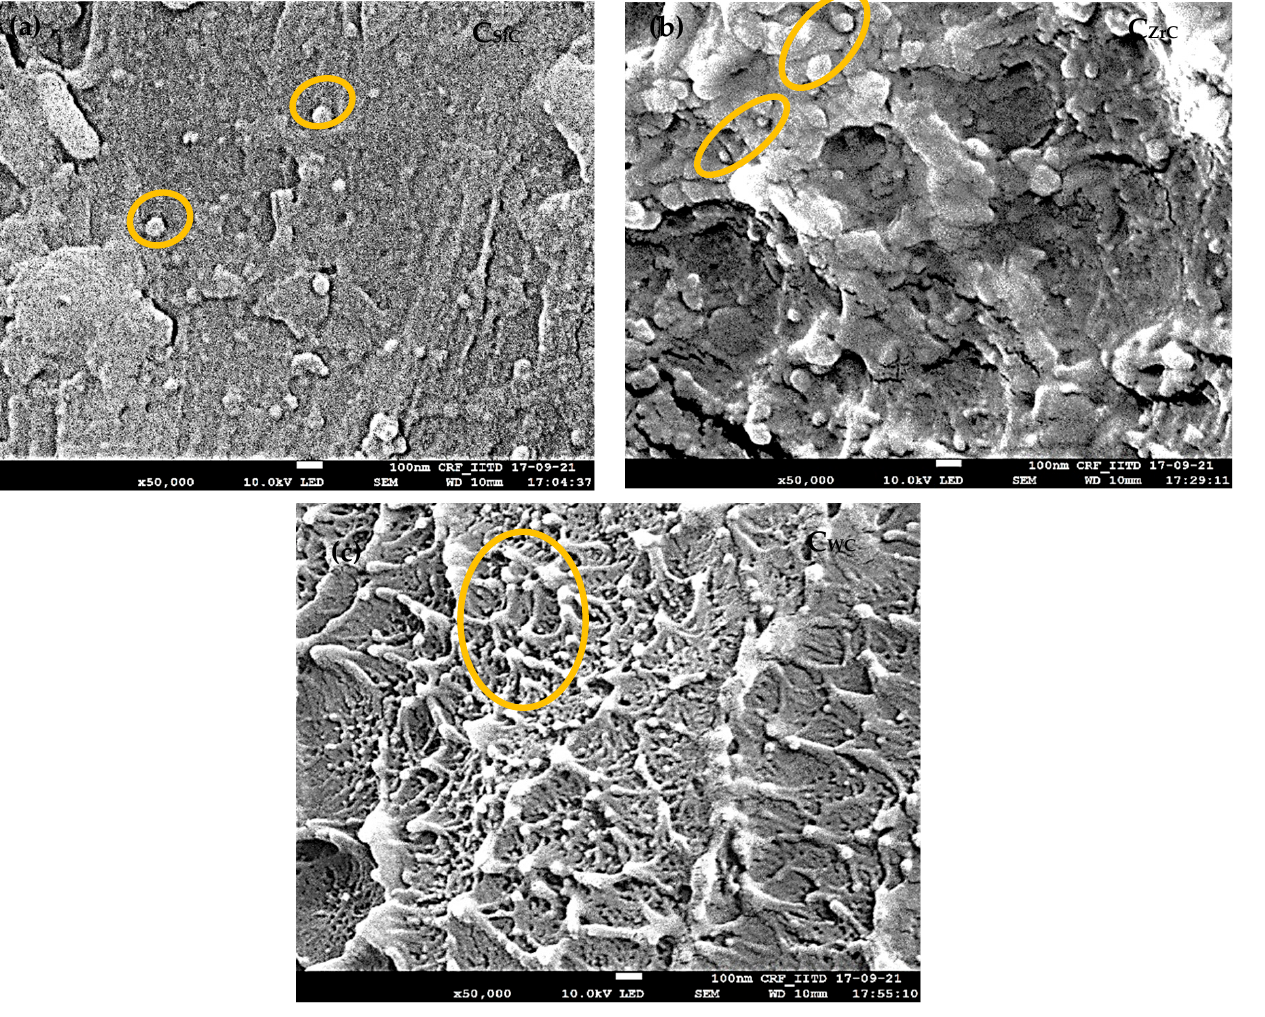
Figure 2. FE-SEM micrographs of films showing dispersion and range of size of NPs; ( a ) C SiC 60–80 nm, ( b ) C ZrC 70–90 nm, and ( c ) C WC 50–70 nm.